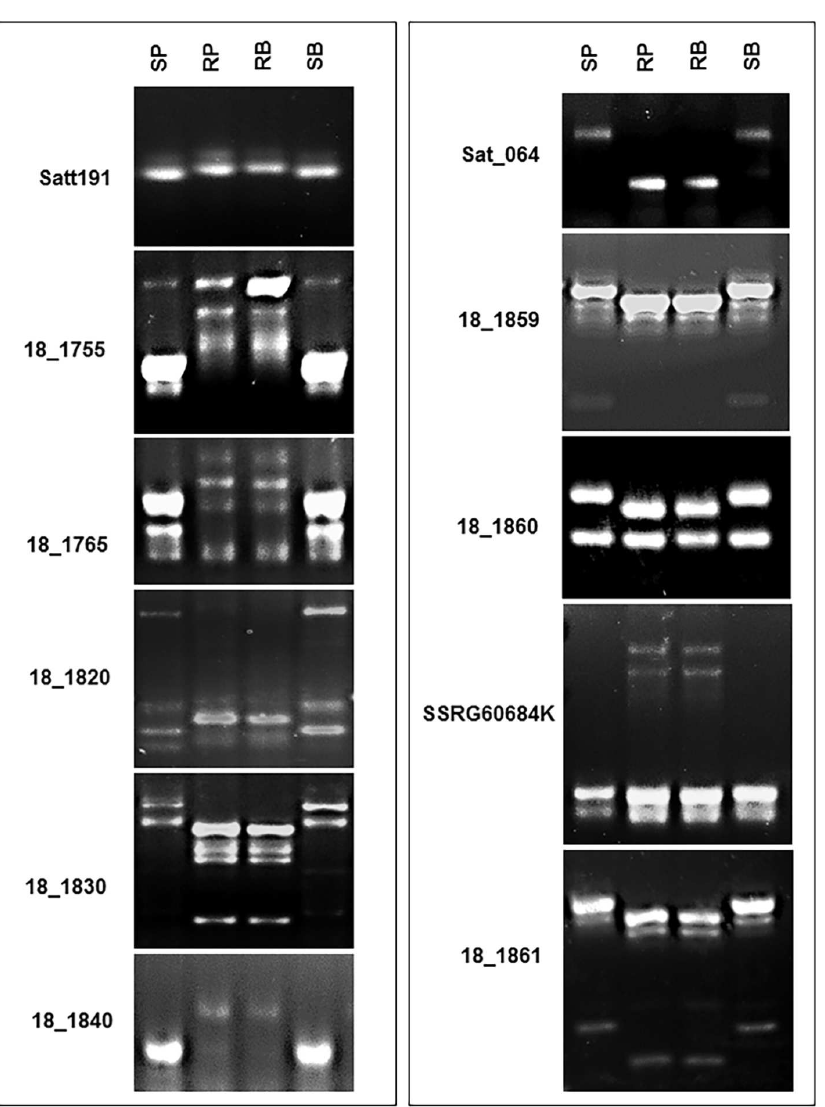
Fig 2. Eleven polymorphic SSR markerslinked to Rps12 . SP, susceptibleparentAR2; RP, resistant parentPI399036; RB, bulkof 10 resistanthomozygous RILs; SB, bulkof 10 susceptibleRILs.